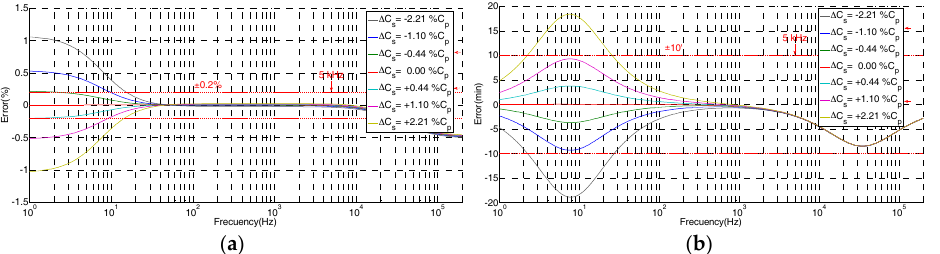
Figure 5. Errors due to different C s values using the simplified model of Figure 3: ( a ) ratio error; ( b )